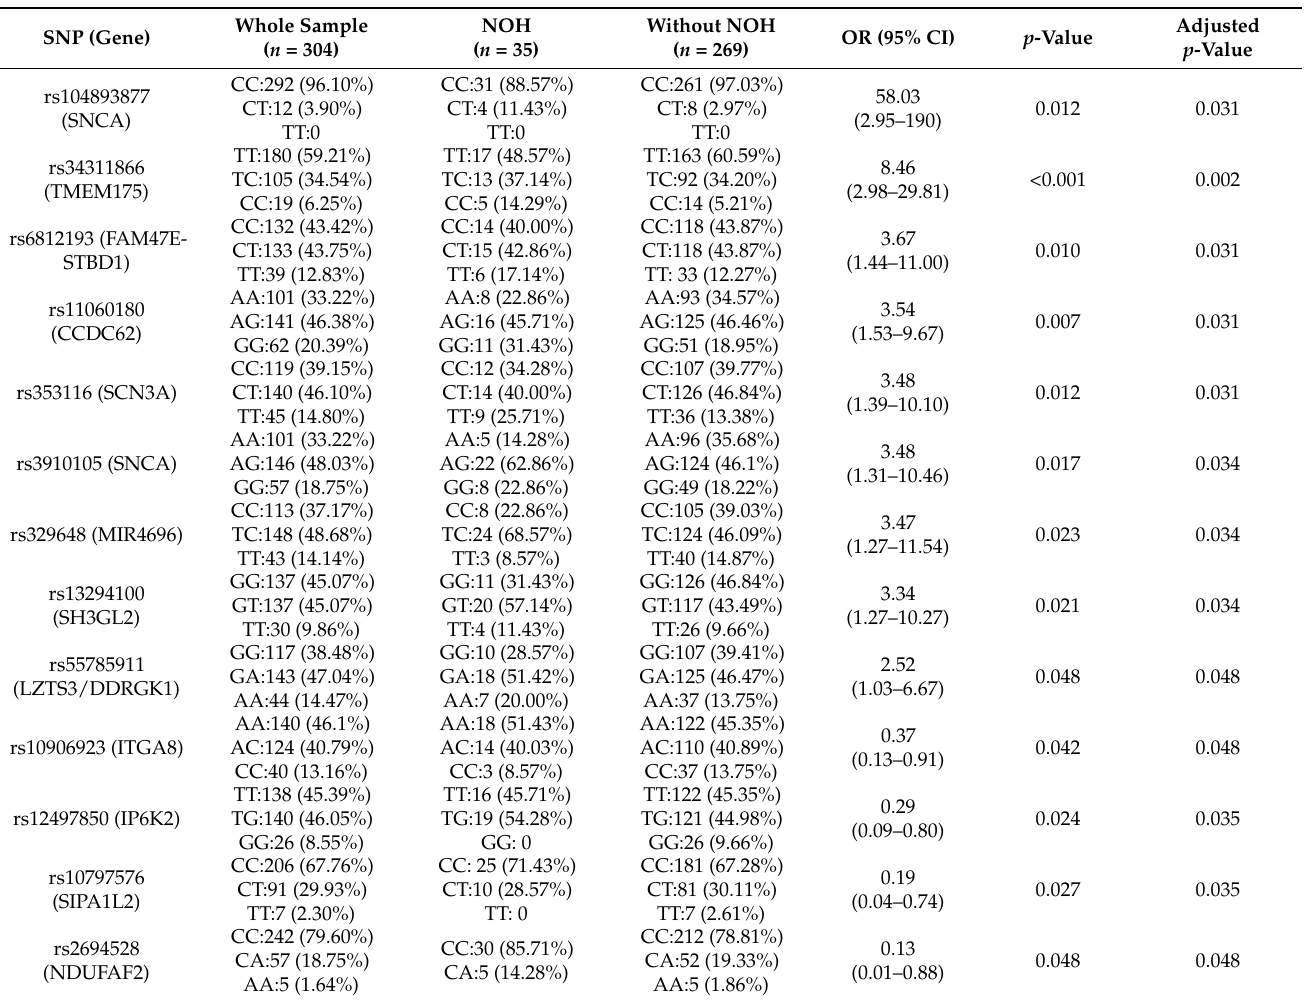
Table 2. SNPs associated with Neurogenic Orthostatic Hypotension in PD by logistic regression analysis.